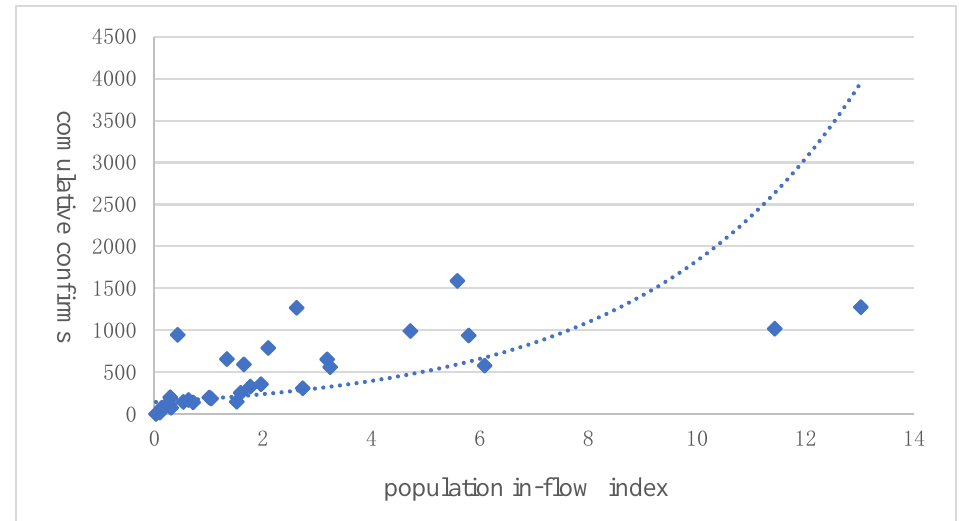
Figure 6. The confirmed cases in COVID 19 and transportation infrastructure in different prov-inces in China. Note: Railway density ( a ) and Road density ( b ) are from China’s National Bureau of Sta- tistics. The number of confirmed cases is from China’s National Health Com mission. The dashed line is the quadratic fitted line..